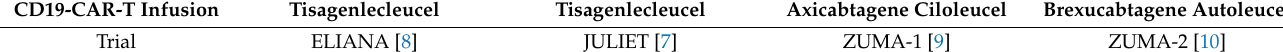
Table 3. Cardiac exclusion criteria for pivotal trials of CD19-CAR-T. ECG: Electrocardiogram. CD19-CAR-T